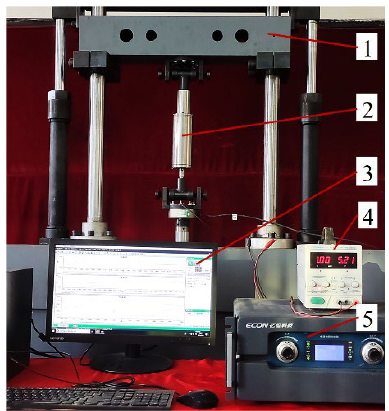
Figure 13. Experimental test rig of MR damper: 1. Vibration excitation platform, 2. proposed MR damper, 3. controlled computer, 4. DC power supply, 5. electro-hydraulic servo controller.